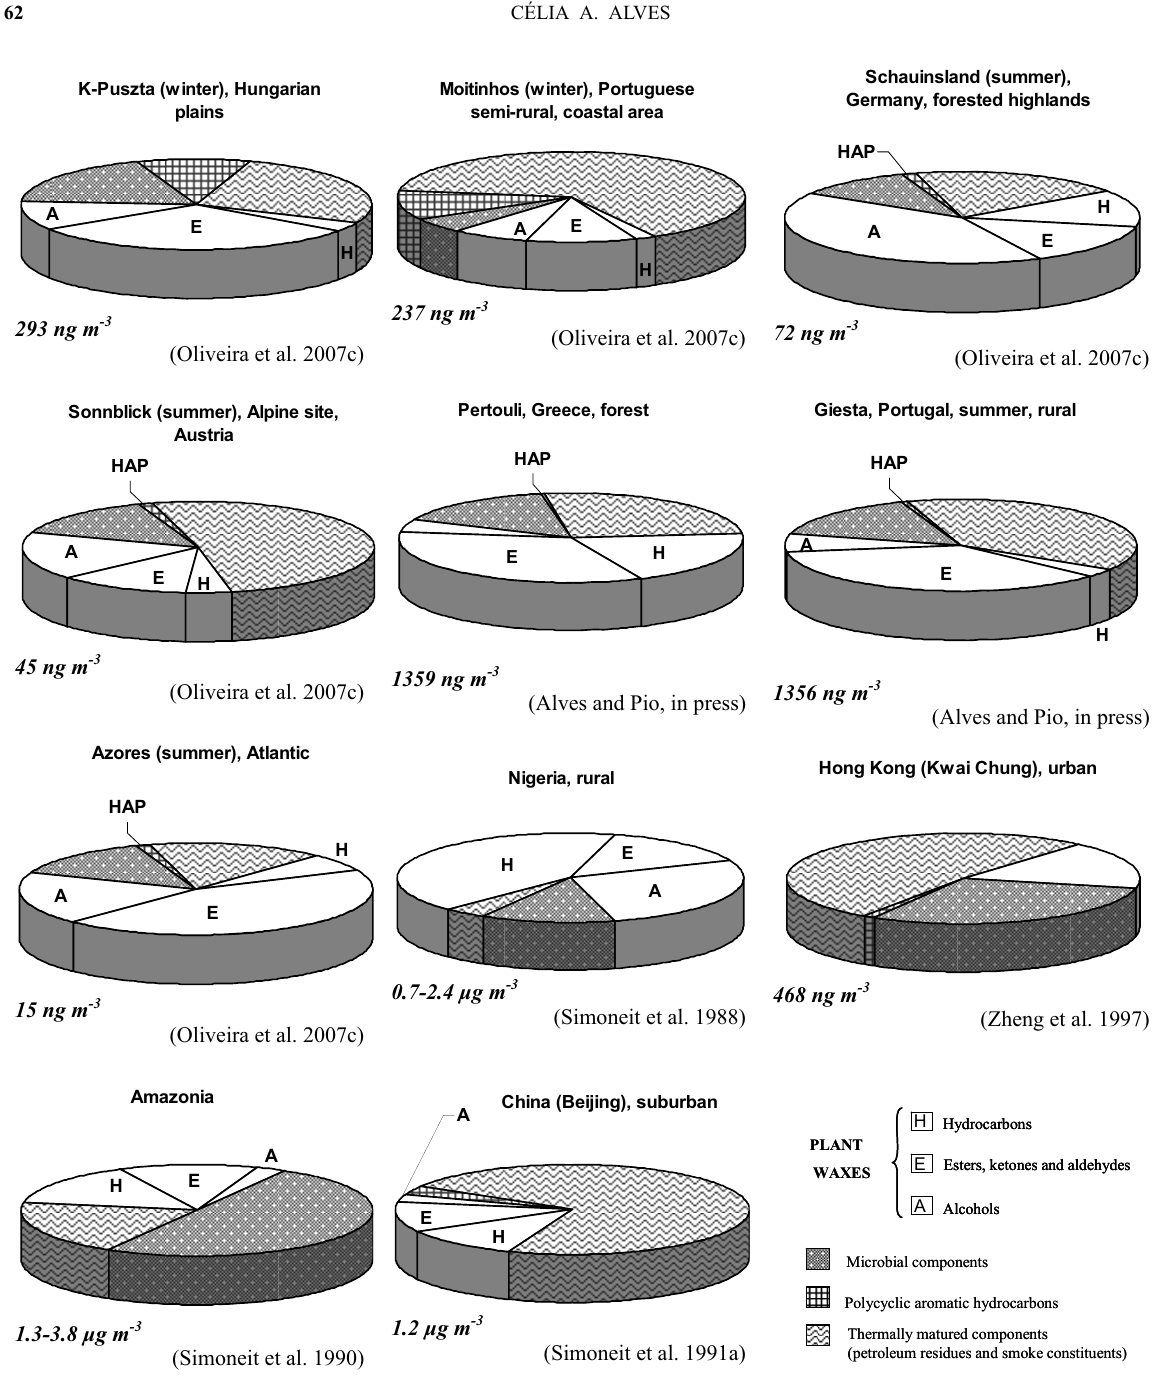
Fig. 6 – Pie diagrams showing the apportionment of various lipid fractions to sources in various regions of the